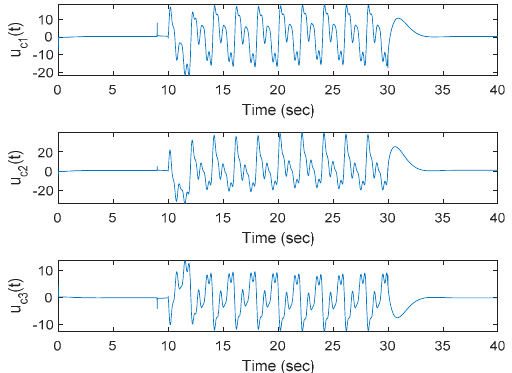
Figure 9. ( a ) Time responses of the proposed method and ( b ) errors of output e ( t ) = r ( t ) − y c ( t ) .